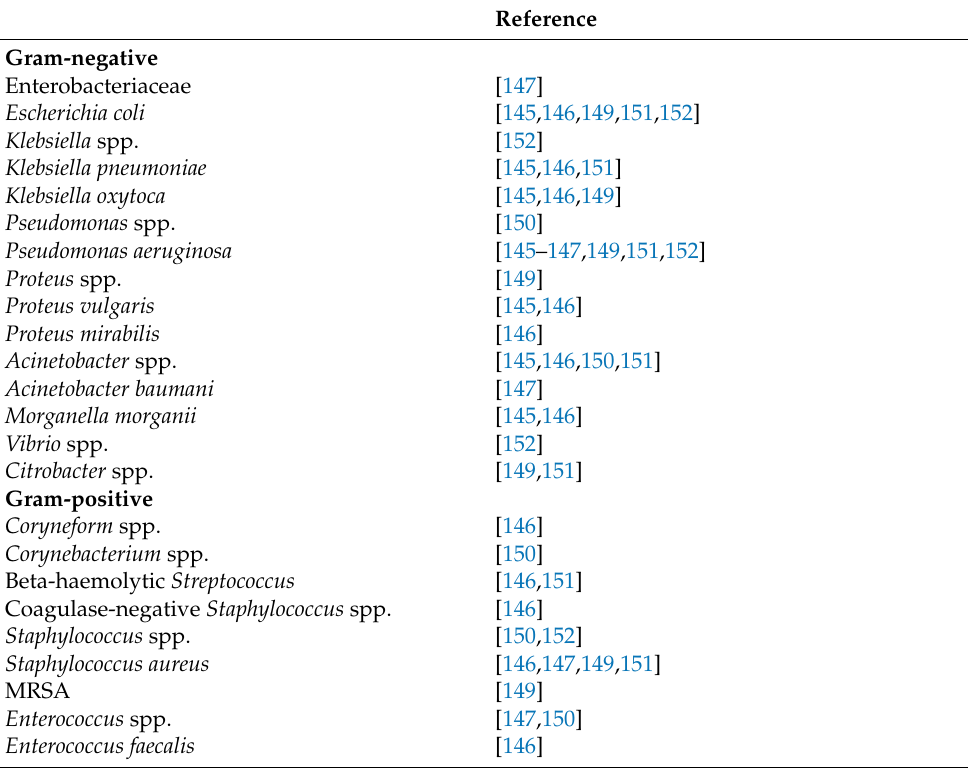
Table 4. The main biofilm-producing bacteria isolated from